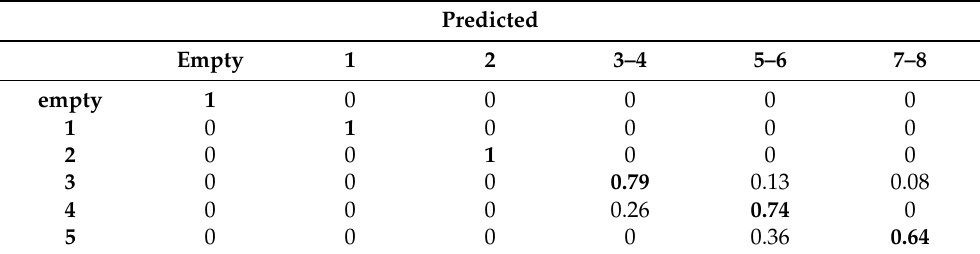
Table 3. Confusion matrix in room B with maximum 8 people and Naïve Bayes